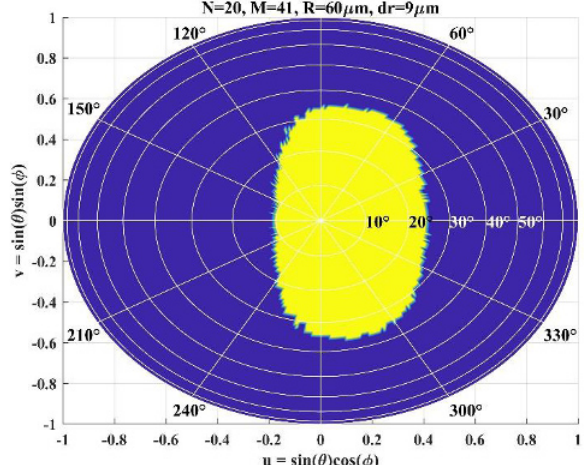
Fig. 4. Steering range of circular array operating at 1550 nm. The yellow area represents the set of all steerable angles where the sidelobe suppression is larger than 10 dB, and the blue area represents non-steerable